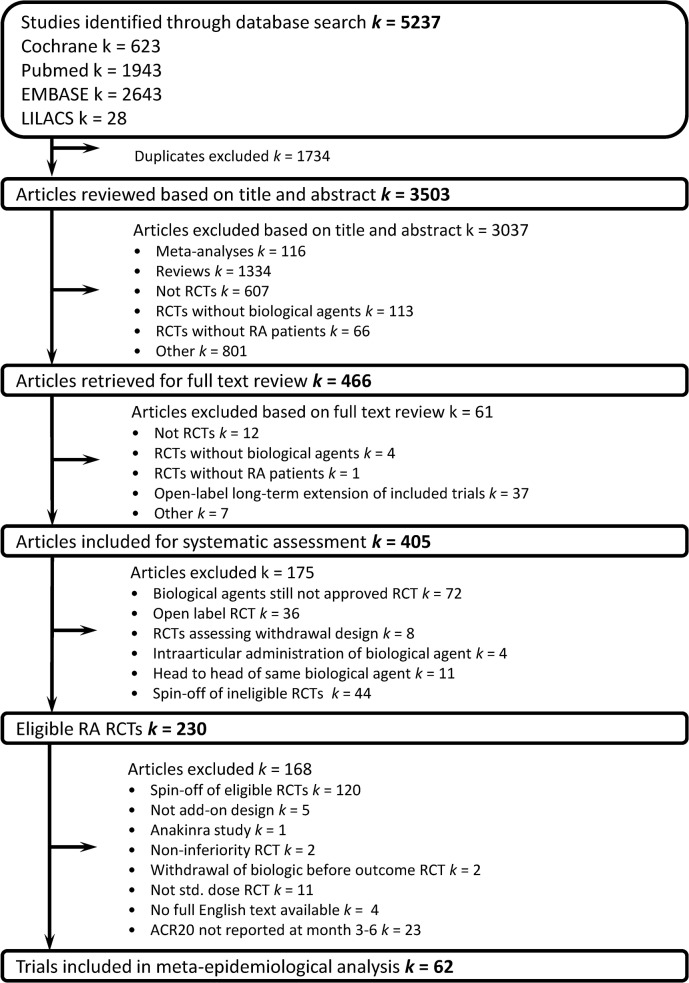
Flow diagram of included randomized controlled trials.RCT, randomized controlled trial; RA, rheumatoid arthritis.